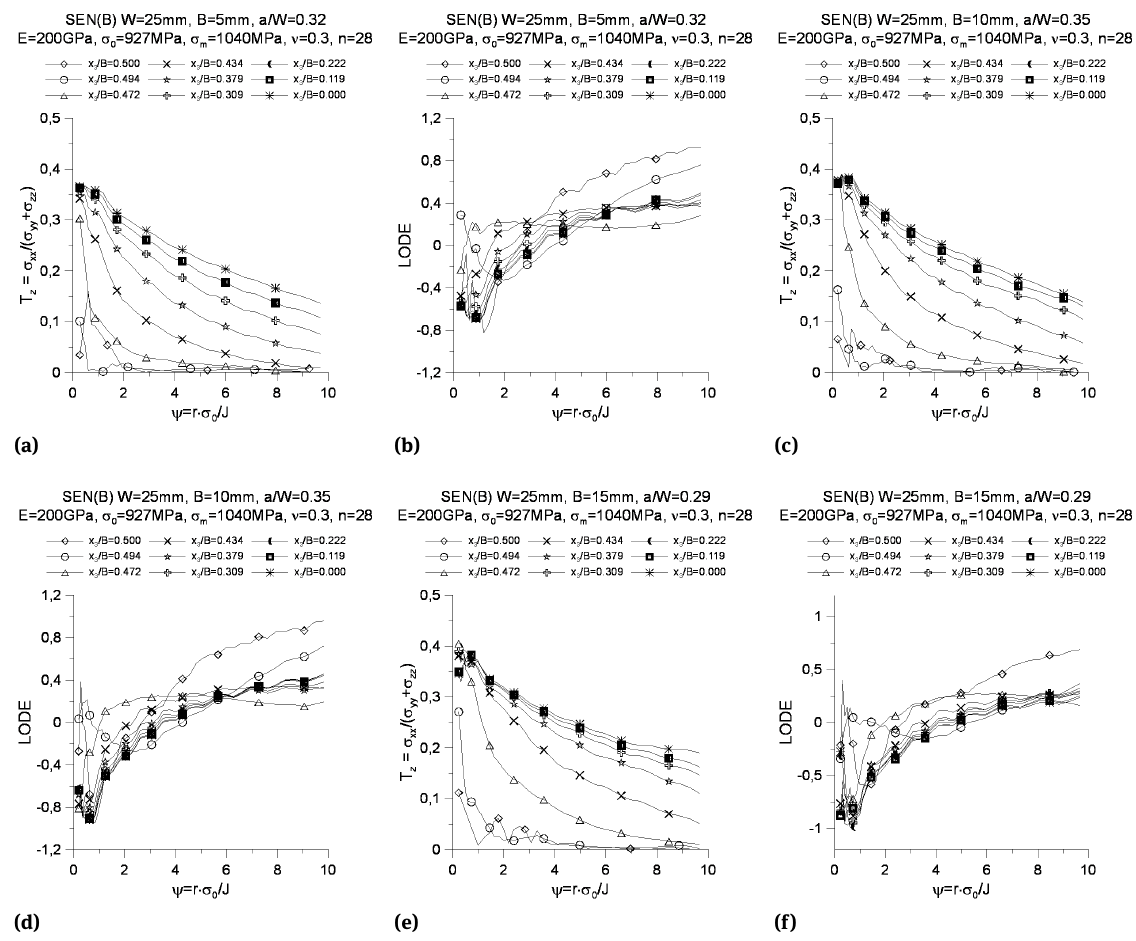
Figure 8: The distributions of the T z parameter defined by Guo Wanlin [23–25] and the LODE parameter, near the crack tip for three SEN(B) specimens made of 145Cr6 steel: a-b) B = 5mm, a / W = 0.32 ; c-d) B = 10mm, a / W = 0.35 ; e-f) B = 15mm, a / W = 0.29 ( x 3 / B = 0.500 –